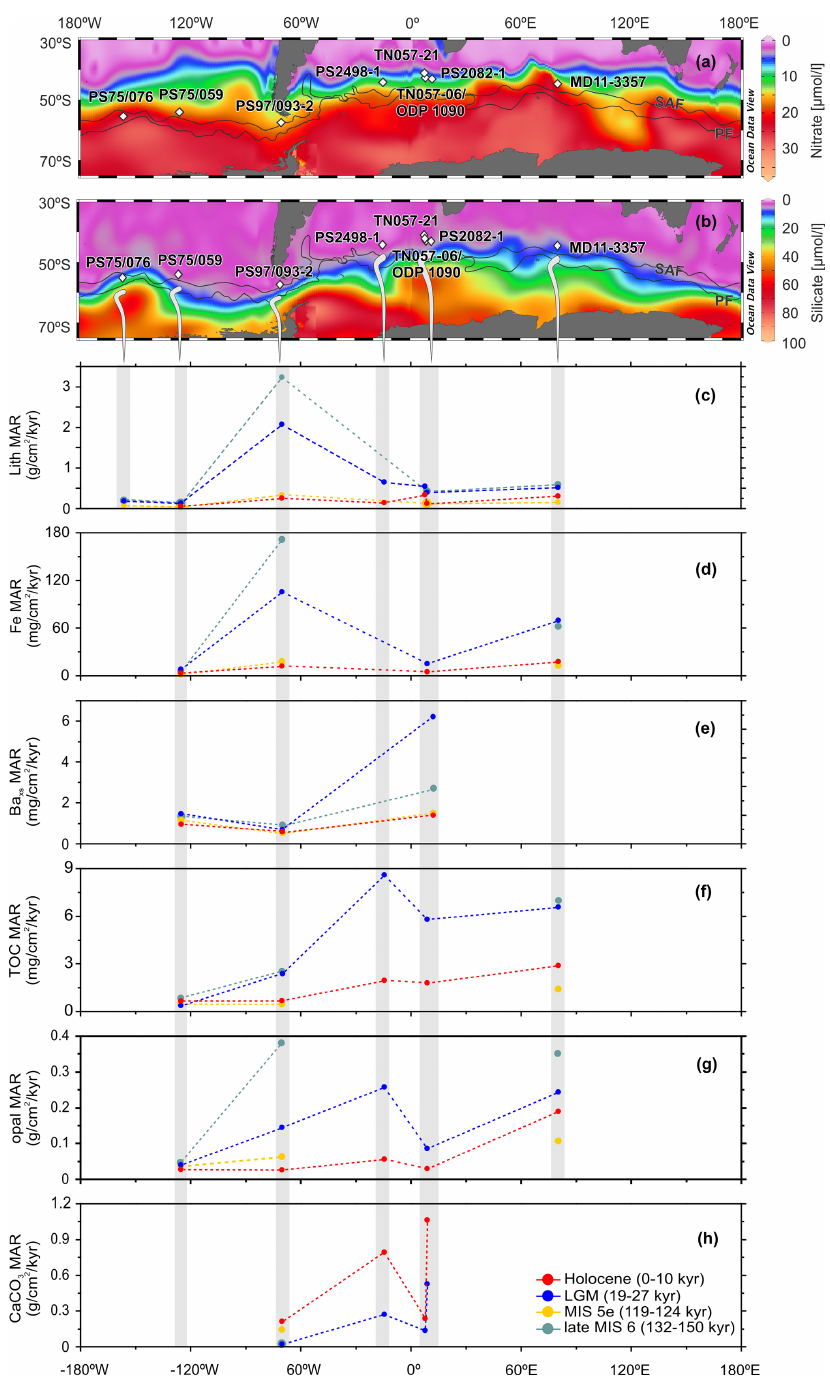
Figure 6. Comparison of MAR across the Subantarctic Southern Ocean, during the Holocene (0–10ka, red), the Last Glacial Maximum (19–27ka, blue), Marine Isotope Stage 5e (119–124ka, yellow), and late Marine Isotope Stage 6 (132–150ka, green): maps of surface water nitrate (a) and silicate (b) concentrations (data from WOCE, Global Hydrographic Climatology, Gouretski and Koltermann, 2004) – black lines indicate the modern location of the Subantarctic Front (SAF), and Polar Front (PF, Orsi et al., 1995), and white diamonds refer to core locations (PS75/076 and PS75/059, Lamy et al., 2014; PS97/093-2, this study; PS2498-1, TN057-21 and TN057-06, Anderson et al., 2014; ODP1090, Martínez-García et al., 2014; PS2082-1, Nürnberg et al., 1997 and Frank, 2002; MD11-3357, Thöle et al., 2019); (c) lithogenic flux; (d) Fe flux; (e) Ba xs flux; (f) total organic carbon flux; (g) opal flux; (h) CaCO 3 flux. Grey bars indicate the projected core positions.